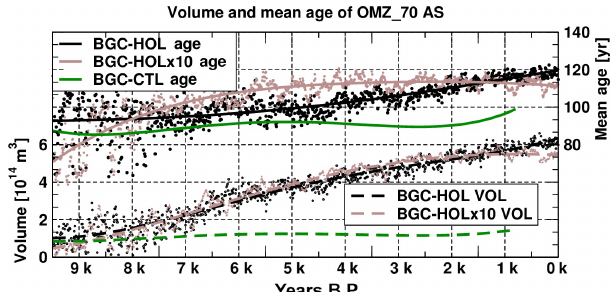
Figure 15. As Fig. 12 but for the Arabian Sea in the area of 55– 75 ◦ E, 8.5–22 ◦ N, 100–800m depth. OMZ volume for a threshold of 70µmolL − 1 in 10 14 m 3 and water mass age in